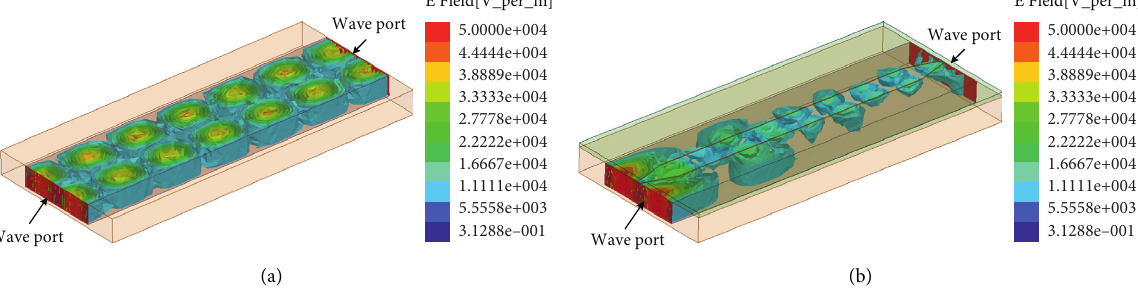
Figure 6: RW and SRW are only excited by TE20 excitation: (a) the E field of RW at 150 GHz and (b) the E field of SRW at